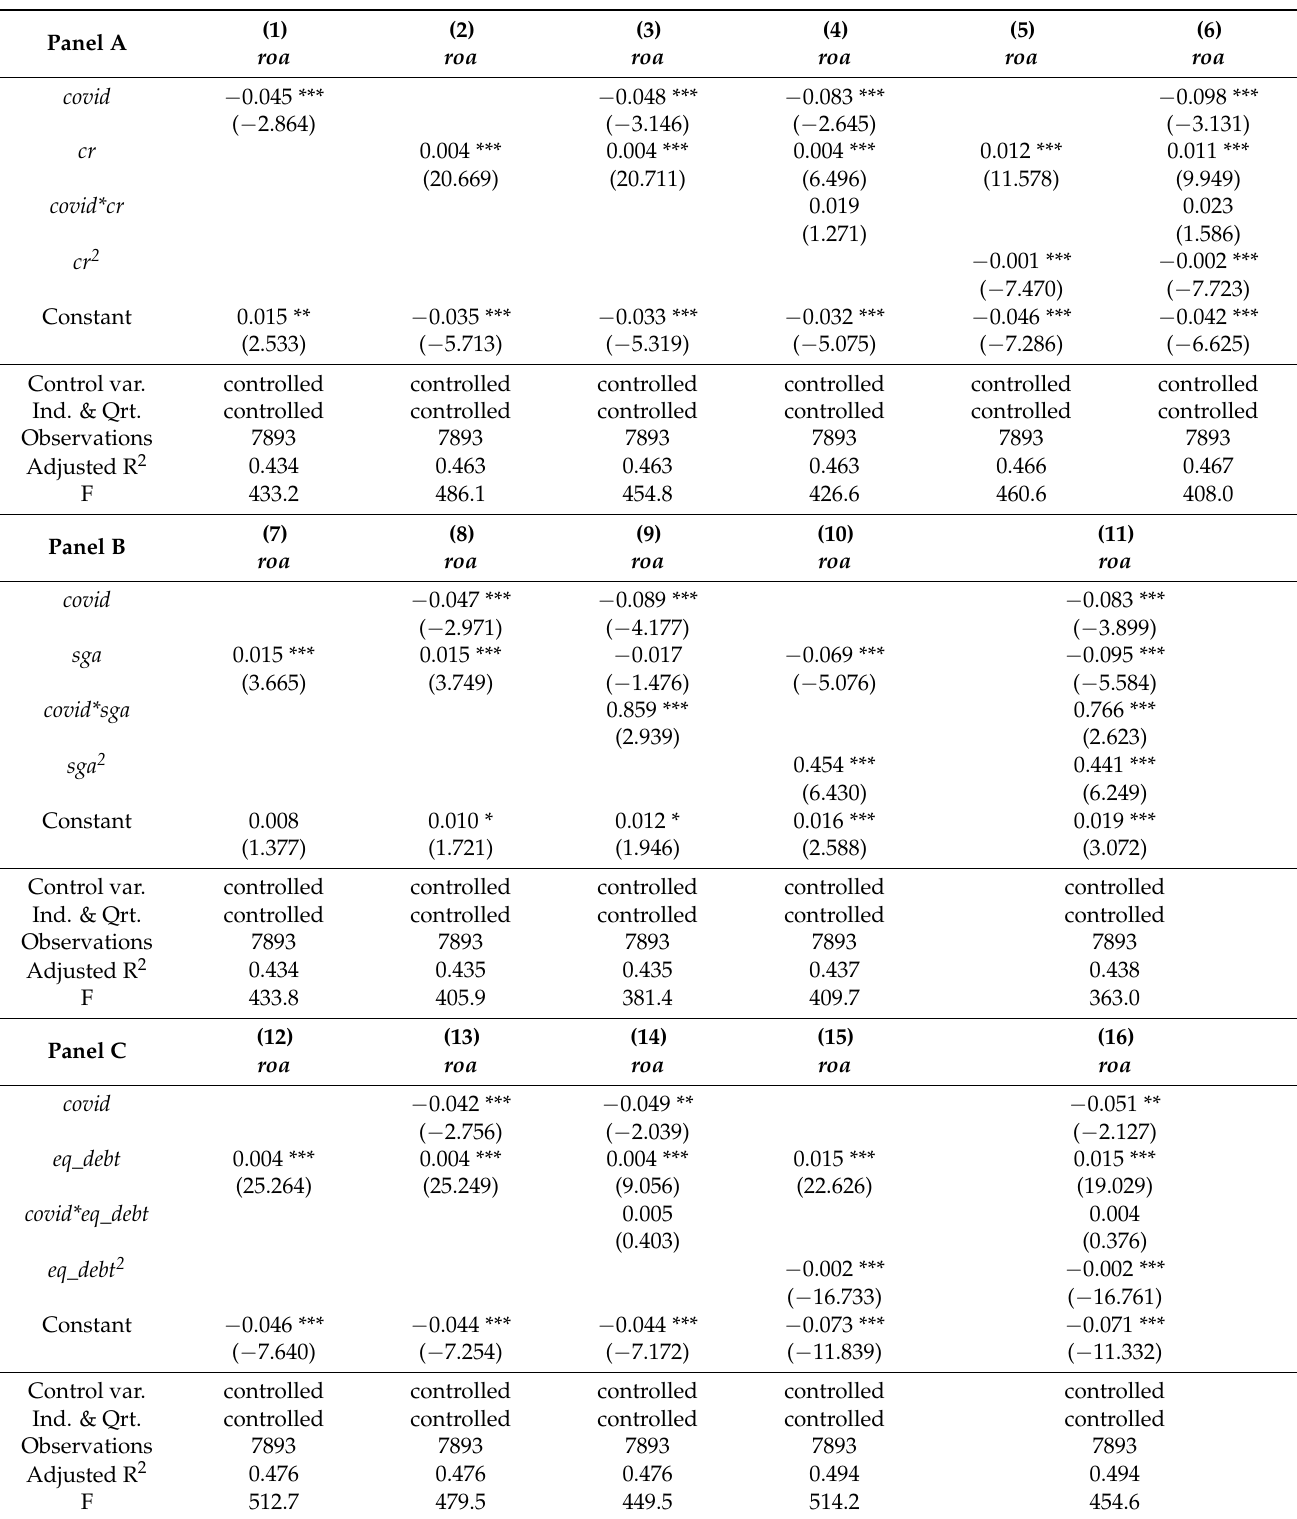
Table 8. Regression Results for H3: Industries impacted negatively by